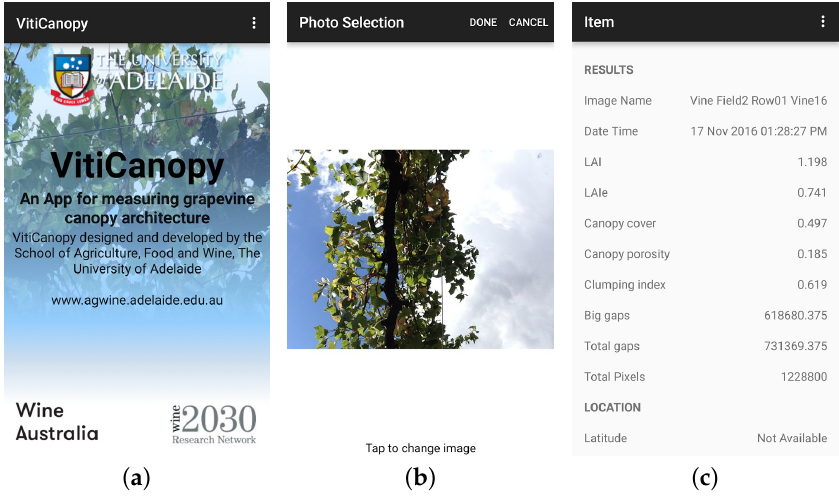
Figure 20. VitiCanopy: ( a ) Main menu; ( b ) Image setection; ( c ) Image processing resulting